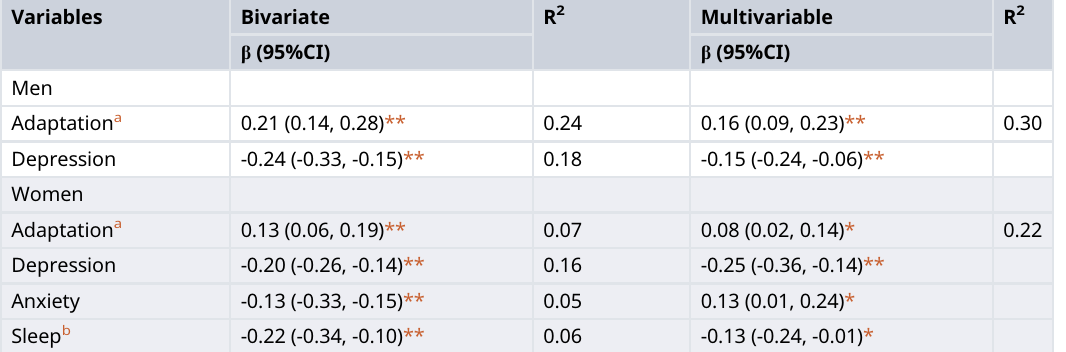
Table 4. Relationship of significant factors to the academic satisfaction of medical students. Variables Bivariate R 2